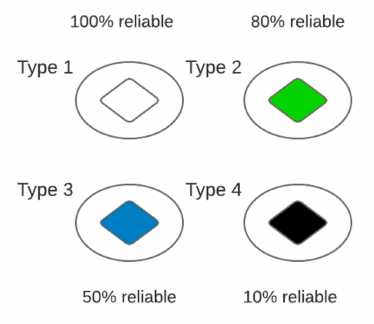
Figure 1. The di ff erent states of product